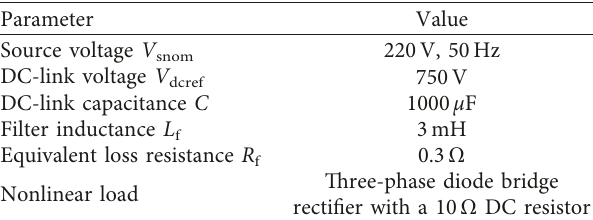
Figure 9: Control block diagram of three-phase three-wire SAPF. Table 1: Simulation model parameters.